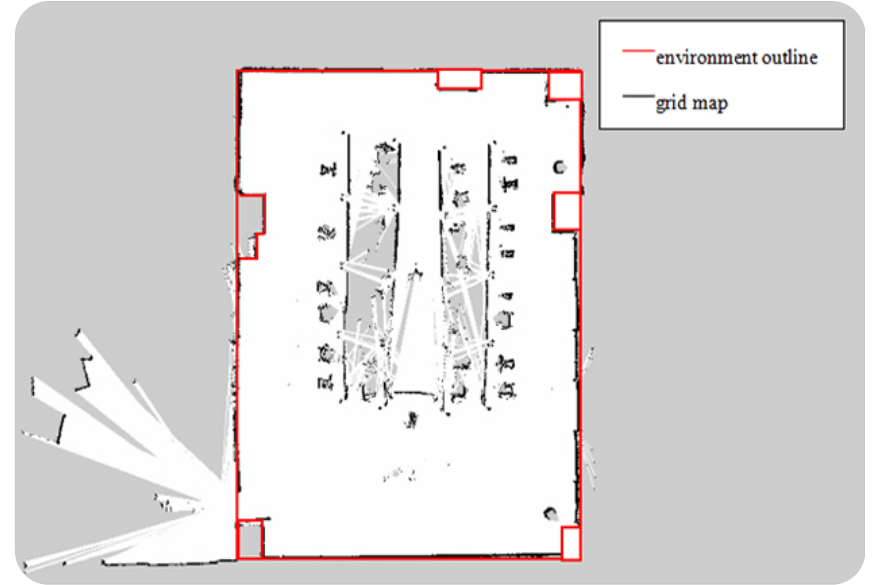
Figure 18. The grid map constructed by the optimized Gmapping mapping algorithm in a small indoor